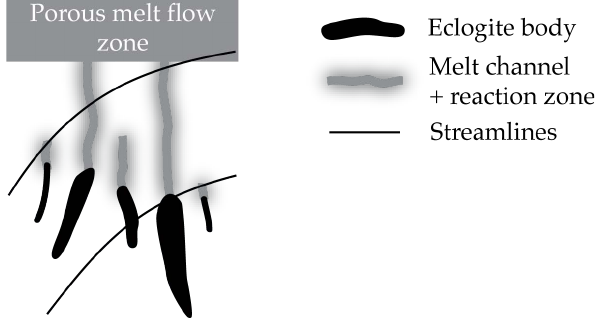
Fig. 14. Sketch of the migration of melt emerging from eclogite bodies. The melt will react with surrounding peridotite, and will tend to refreeze. Some might react completely and become trapped in the mantle, whereas other melt might migrate a significant dis- tance and reach the peridotite melting zone. Curves suggest stream- lines of the mantle flow. After Davies (2009b). Copyright American Geophysical